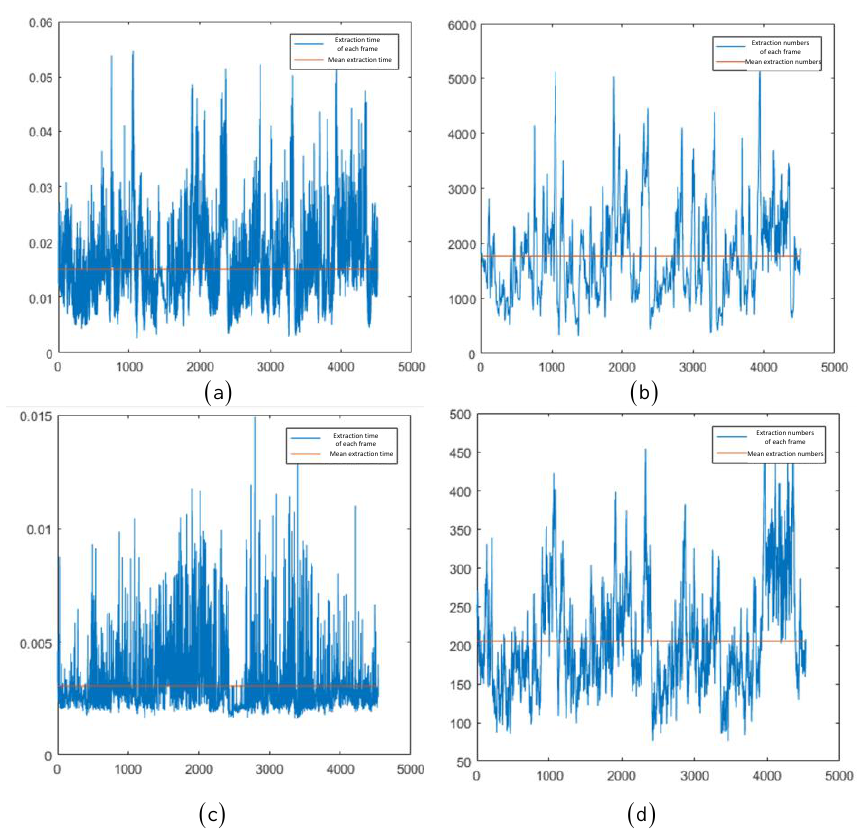
Figure 9. FAST and L-FAST extraction times and extracted number of point features diagrams for KITTI-00. The images ( a , b ) were taken by FAST; ( c , d ) were taken by L-FAST. The vertical axes of ( a , c ) represents time in seconds; the vertical axes of ( b , d ) represent numbers.